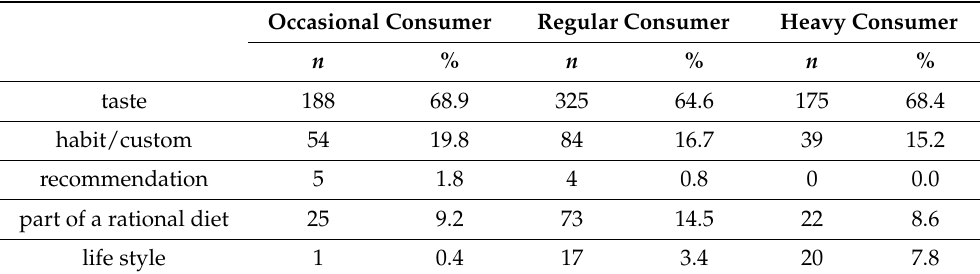
Table 7. Reasons for edible mushrooms consumption in individual segments of edible mush- rooms